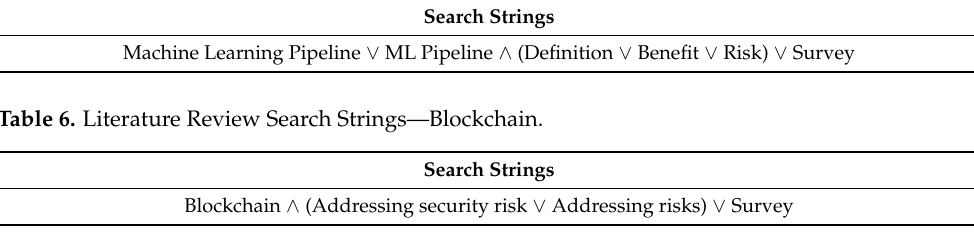
Table 7. Literature Review Search Strings—Combination of ML Pipeline and Blockchain. Search